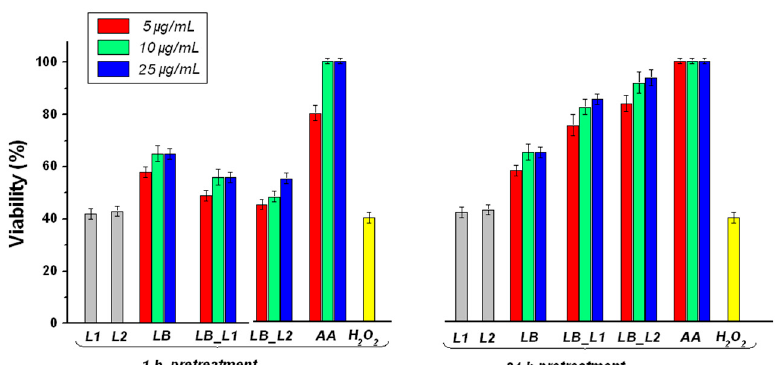
Figure 3. The effect of L. barbarum on L-929 cells; pretreatment 1 h or 24 h before applying H 2 O 2 ; LB—L. barbarum; LB_L1—liposomes loaded with L. barbarum ; LB_L2—liposomes loaded with L. barbarum (formulation with sodium cholate); AA—acid ascorbic; controls: L1—empty liposomes; L2 —empty liposomes with sodium cholate.